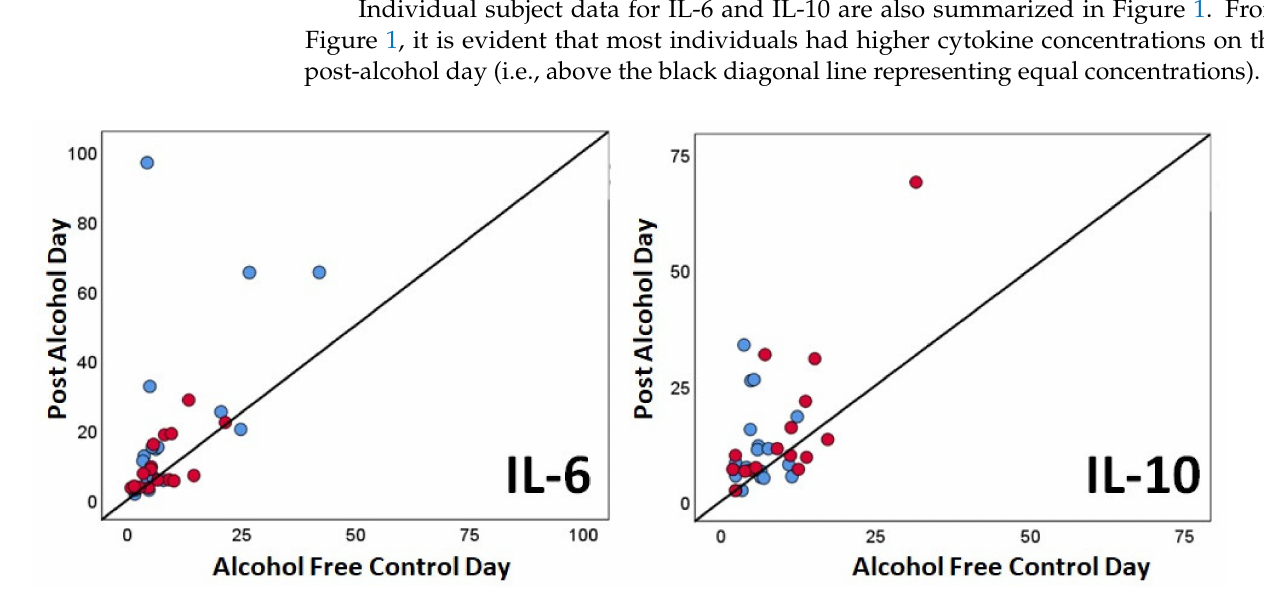
Figure 1. Mean (SD) saliva cytokine concentrations. Individual subject data from the hangover-sensitive group (red markers) and hangover-resistant group (blue markers) are shown for interleukin (IL)-6 and IL-10, which were both significantly increased on the post-alcohol